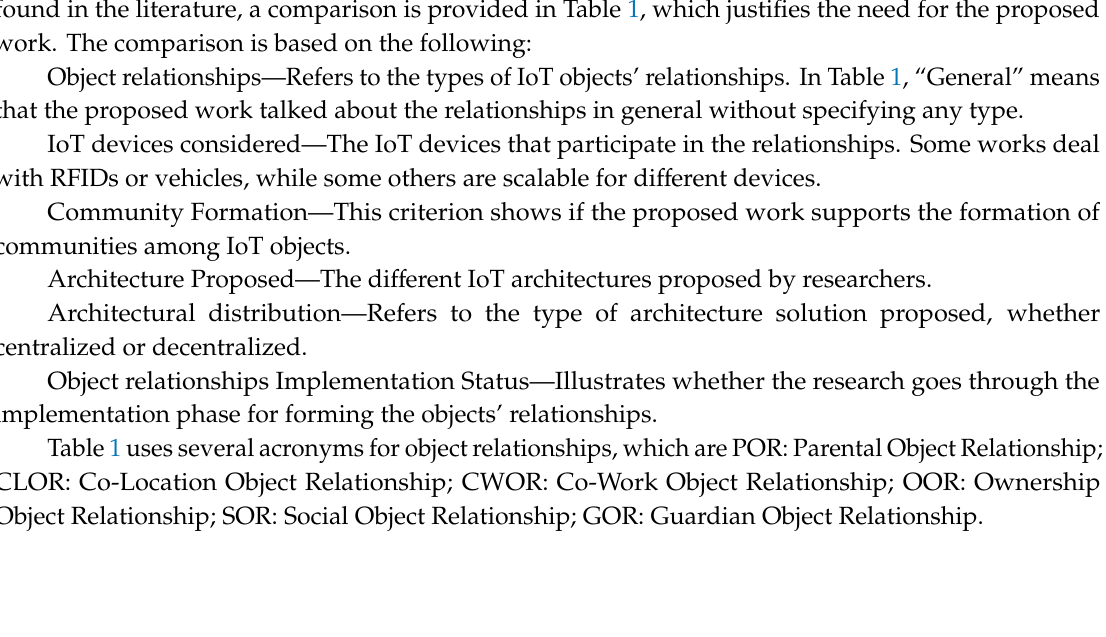
CLOR: Co-Location Object Relationship; CWOR: Co-Work Object Relationship; OOR: Ownership Object Relationship; SOR: Social Object Relationship; GOR: Guardian Object